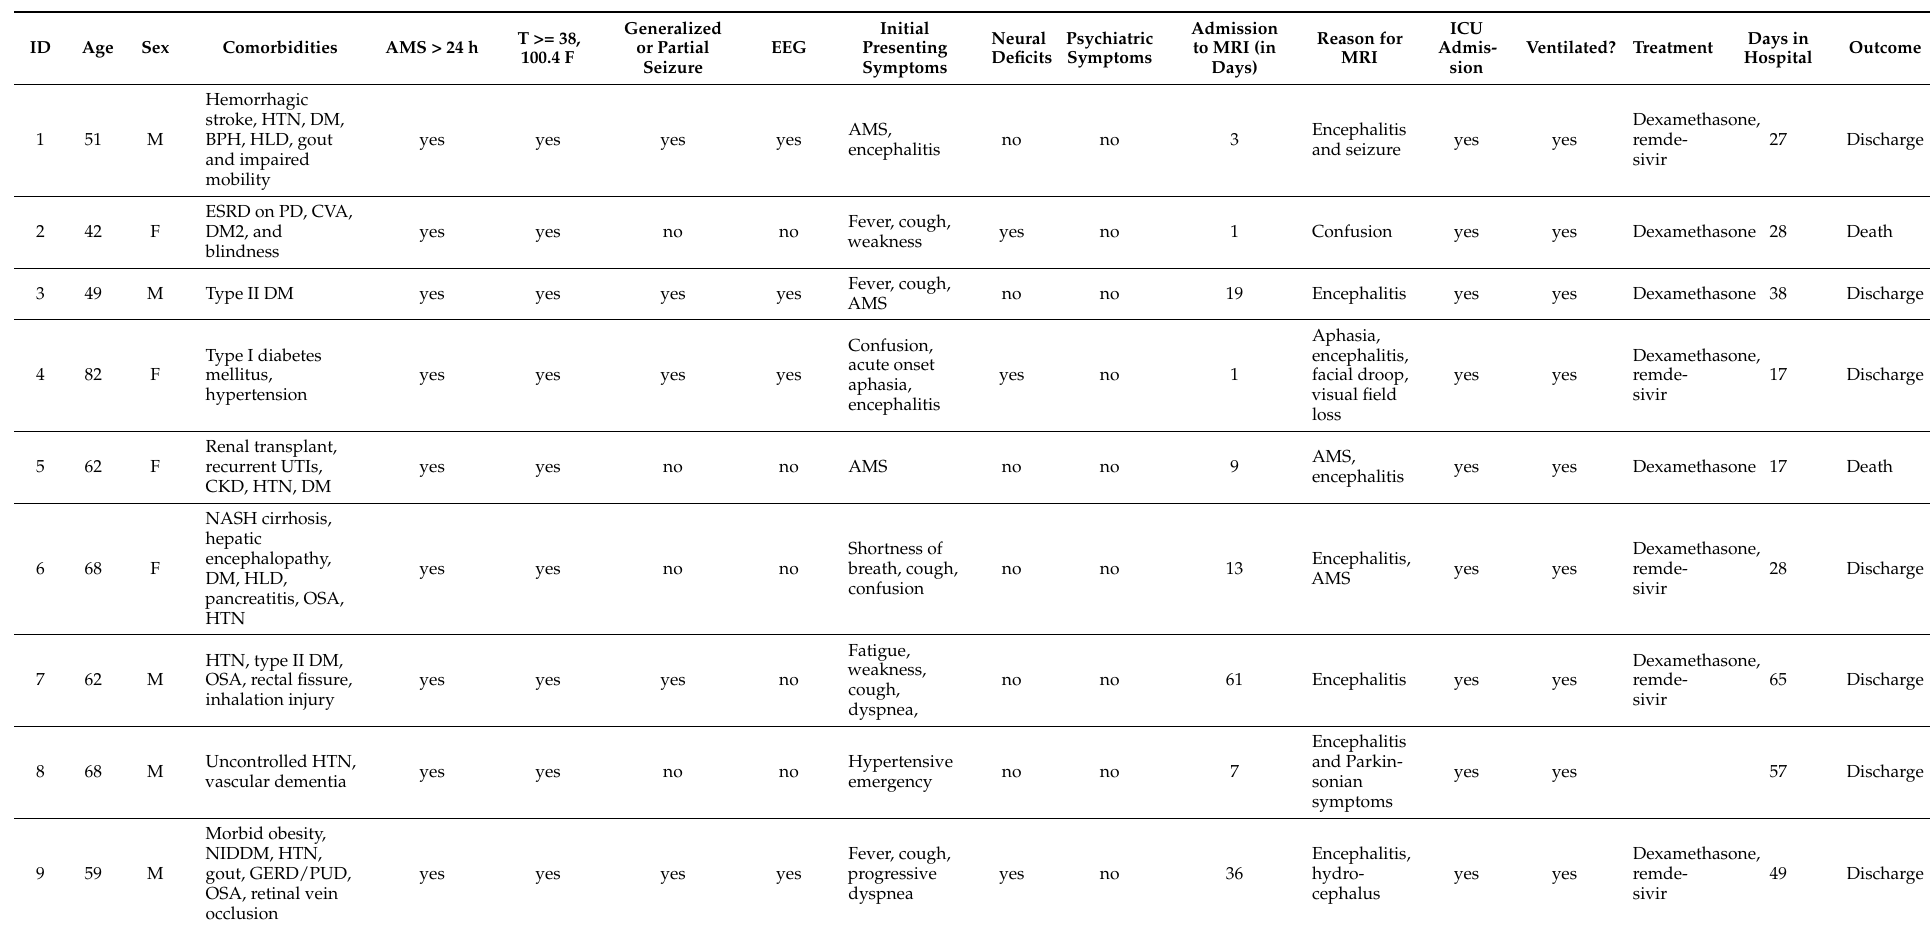
Table 2. Clinical Characteristics of the